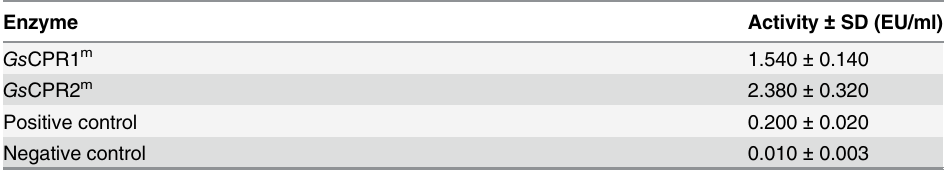
Table 1. Enzyme activity of Gs CPR1 and Gs